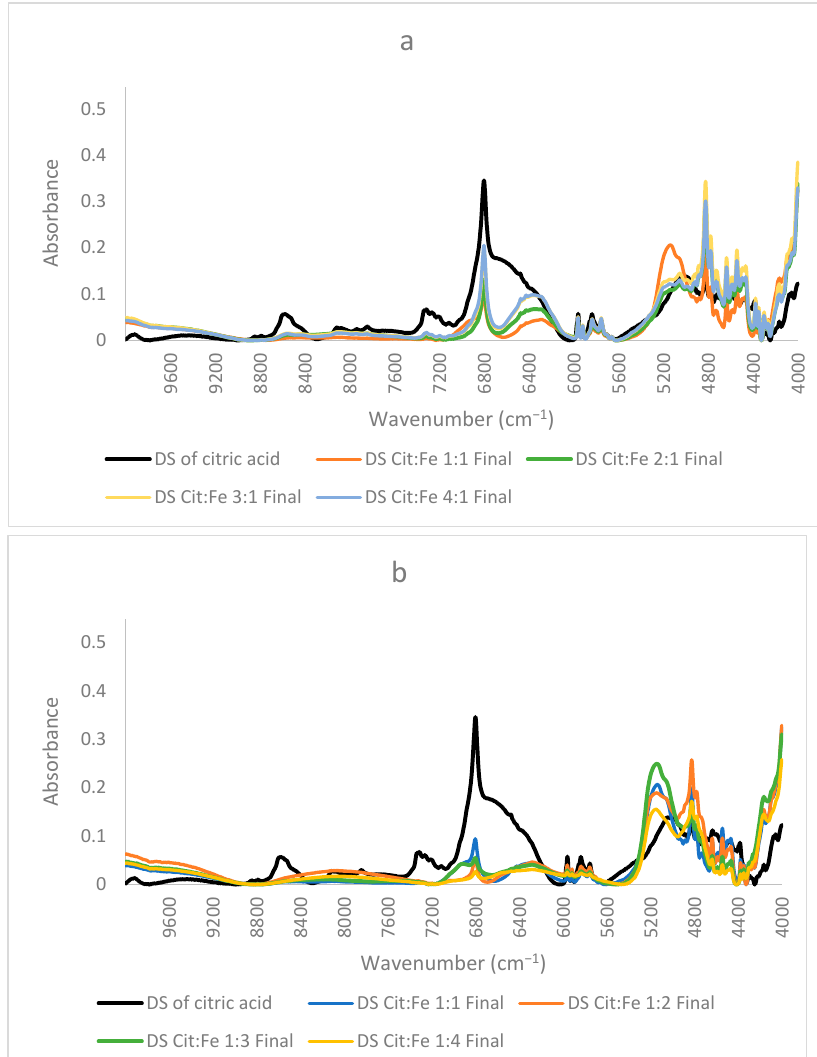
Figure 6. NIR spectra of dried solutions of citric acid and samples prepared at lower concentrations ( a ) ratios 1:1,2:1, 3:1,4:1 ( b ) 1:1, 1:2, 1:3 and 1:4.